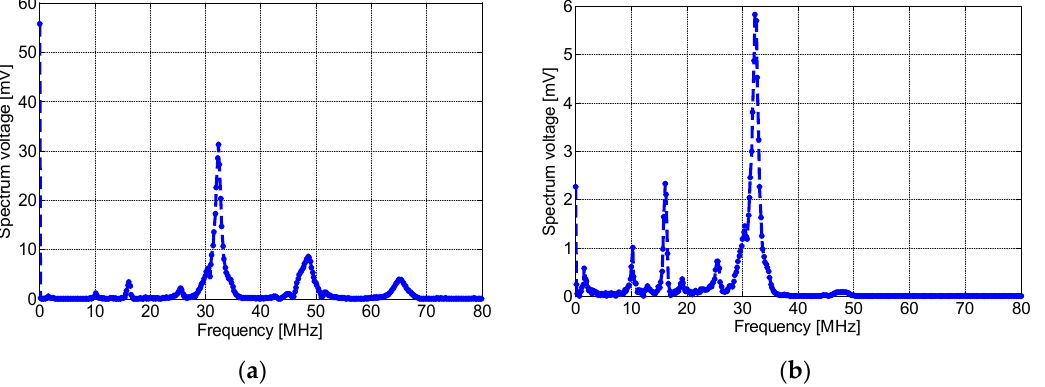
Figure 13. Frequency spectra detected by the: ( a ) non-spiral, and ( b ) meander, inductive sensors when placed at 10 cm away from the defective cable.